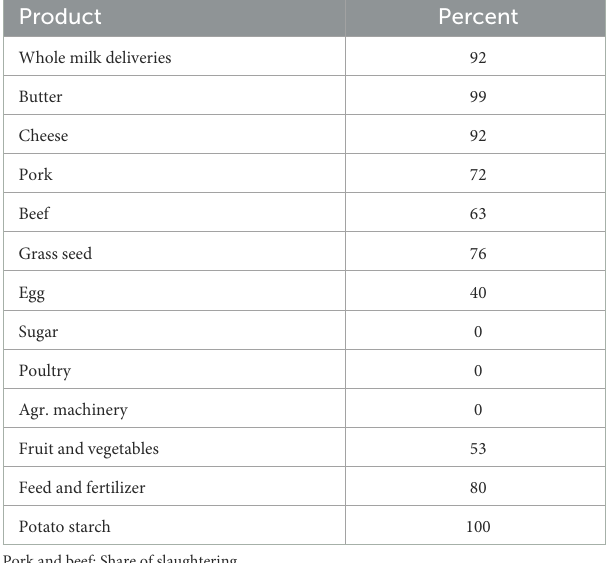
Porkandbeef:Shareofslaughtering. Eggs:Themajorshareholdingeggcompanyownedbyfarmercooperativesisnotincluded. Fruitandvegetables:Freshproductsfordirectconsumption.